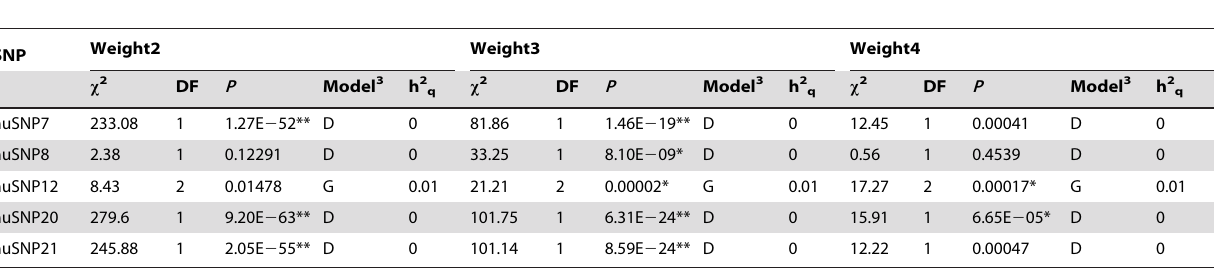
Table 2. Family-based association analysis of nuclear SNPs with growth traits 1 using the R package GWAF 2 .